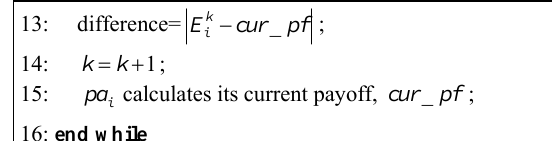
pa make its bidding i